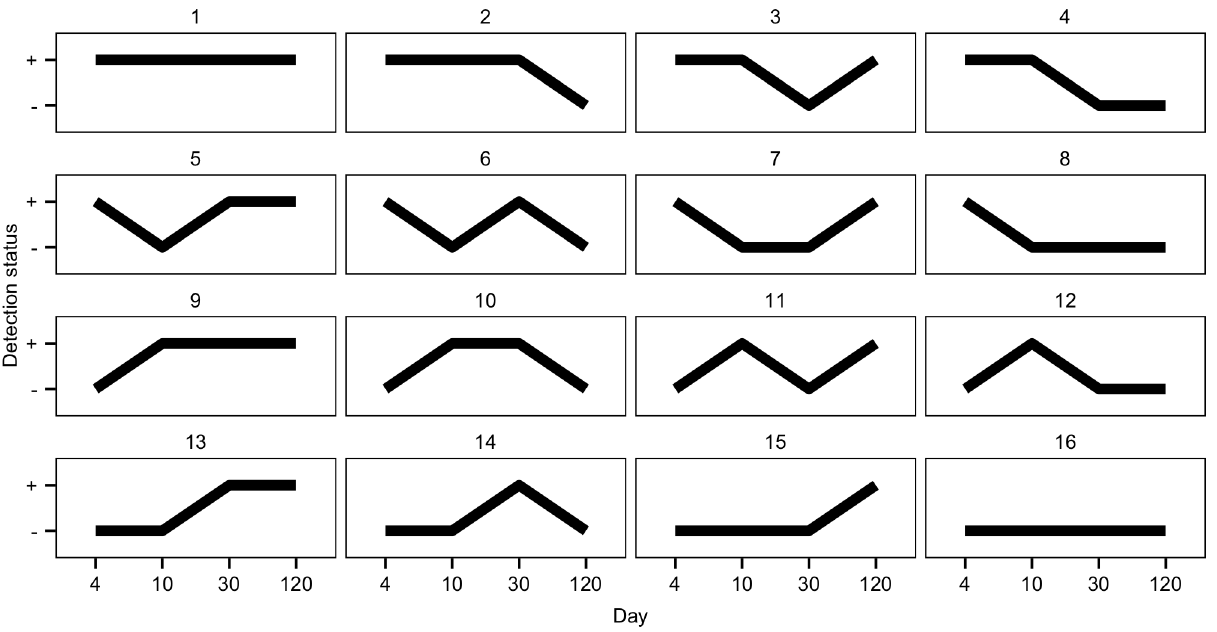
Figure 2. All possible exposure patterns in the data. ‘‘ z ’’ and ‘‘ { ’’ represent detection and non-detection respectively. For example, pattern 8 indicates detection at day 4, followed by non-detection at days 10, 30, and 120.